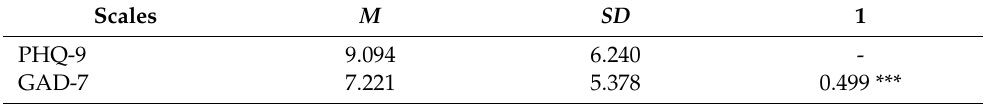
Table 7. The PHQ-9 and the GAD-7: descriptive statistics and correlations between the scales. Scales